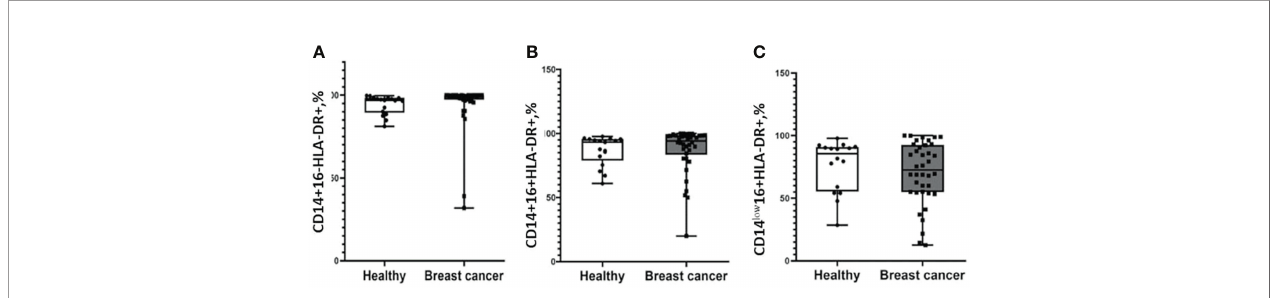
FIGURE 1 | Patients with breast cancer and healthy female individuals have a similar distribution of HLA-DR-positive monocytes. Flow cytometry analysis of CD14+ 16-HLA-DR+ (A) , CD14+16+HLA-DR+ (B) , and CD14 low 16+HLA-DR+ (C) . Patients with breast cancer n = 38; healthy female individuals n = 17. Statistical analysis was performed by the Wilcoxon test.